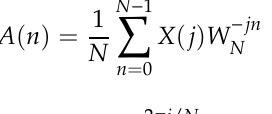
Figure 2. Three-cycle time series samples of stator current signal from five motor conditions with three loading variations—0%, 50% and 100% coupled loading.